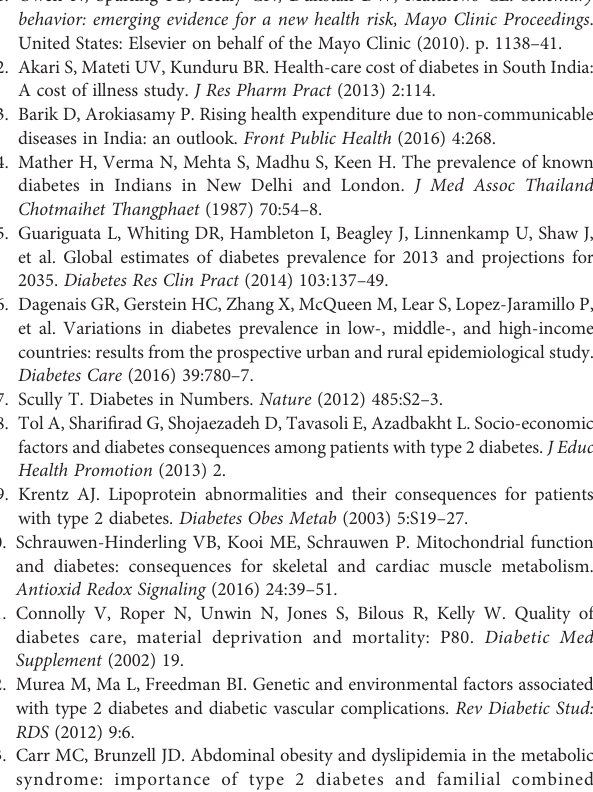
SUPPLEMENTARY TABLE 1 | Assessments phase. SUPPLEMENTARY TABLE 2 | Diet information.